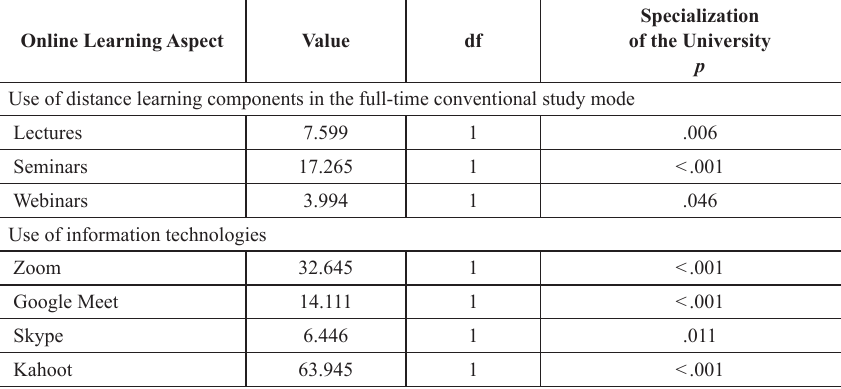
Table 11. Significance of differences between attitudes towards online learning aspects according to specialization (H ), Chi-square test 0–3